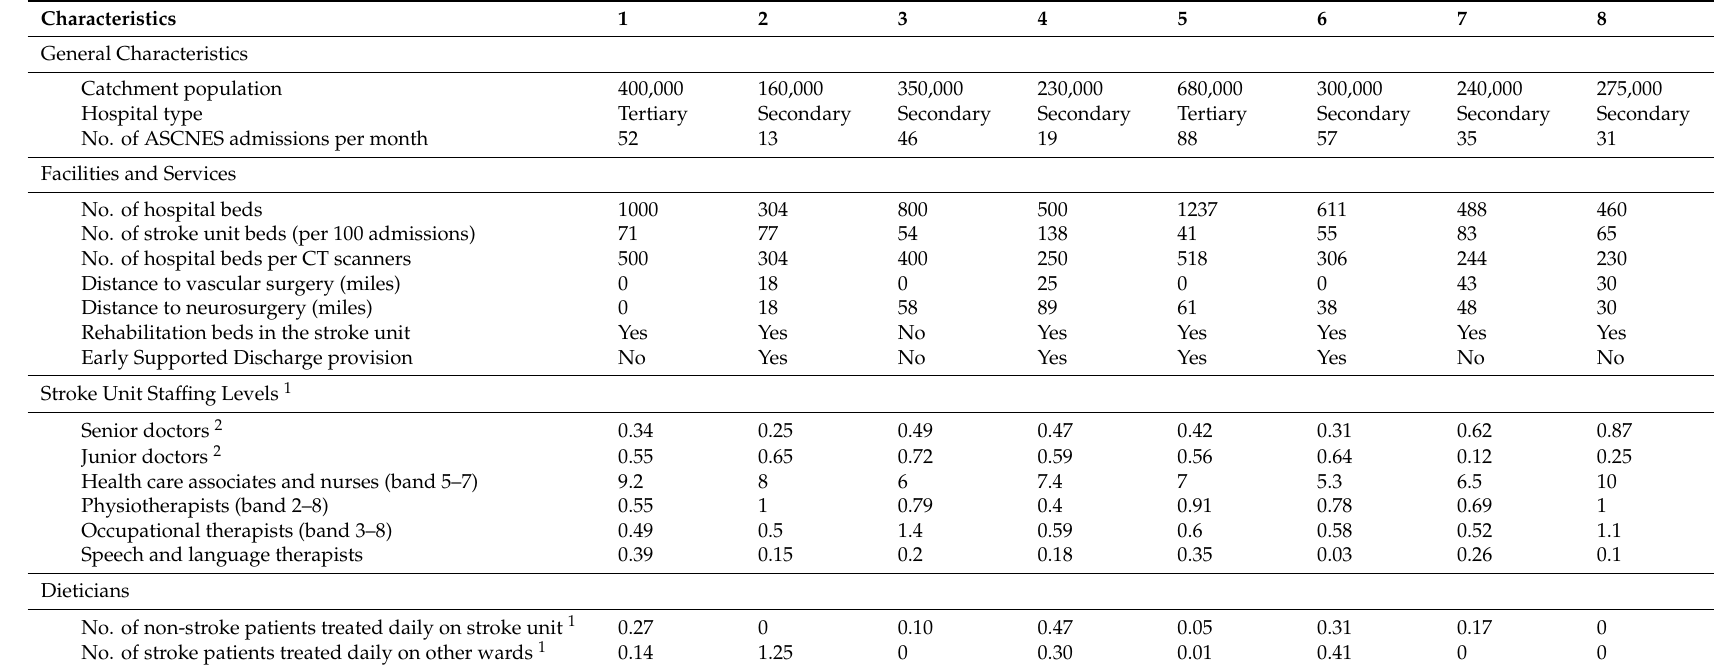
Table 3. Hospital characteristics per individual